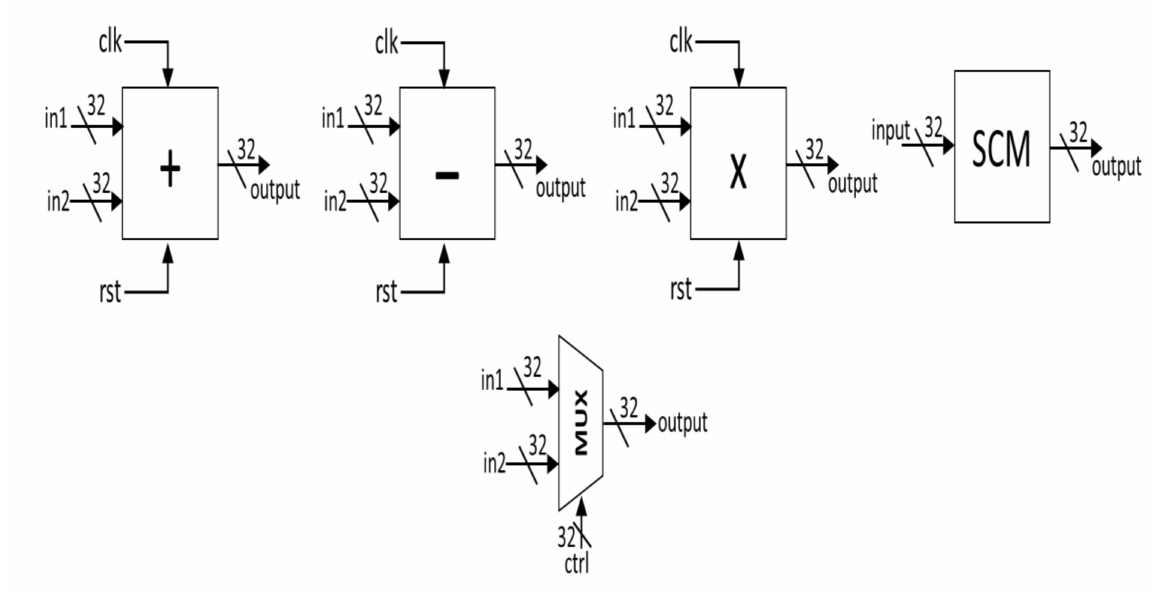
Figure 16. Basic blocks for the three sub-circuits of the discrete-time chaotic system (9). The Adder, Subtractor, and Multiplier blocks are sequential blocks with both clock (clk) and reset (rst) signals. The Single Constant Multiplier (SCM) performs a multiplication of the input by a constant with the use of only adders, subtractors, and shift operations. The Multiplexer (MUX) block chooses one of the inputs depending on the control